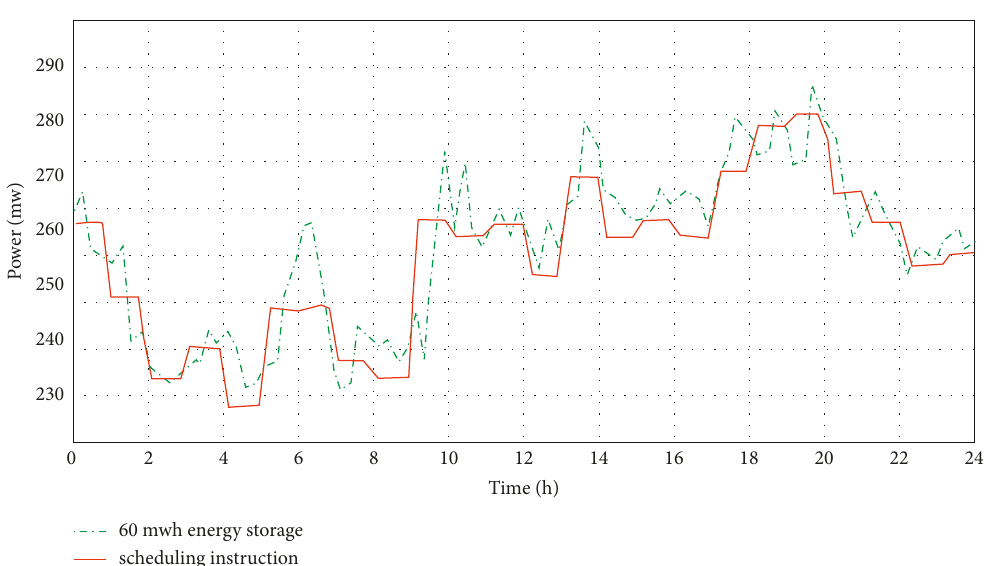
Figure 4: Effect diagram of wind/storage system composite output stabilization